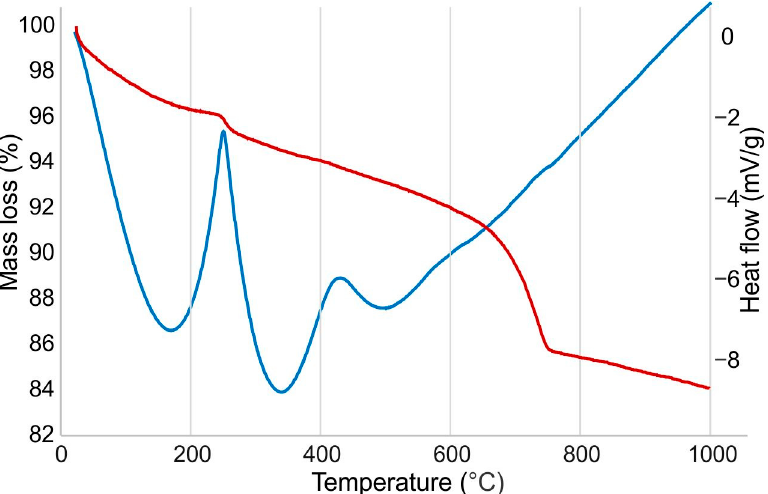
Figure 4. DTA/TGA curves of mixed C&D waste.